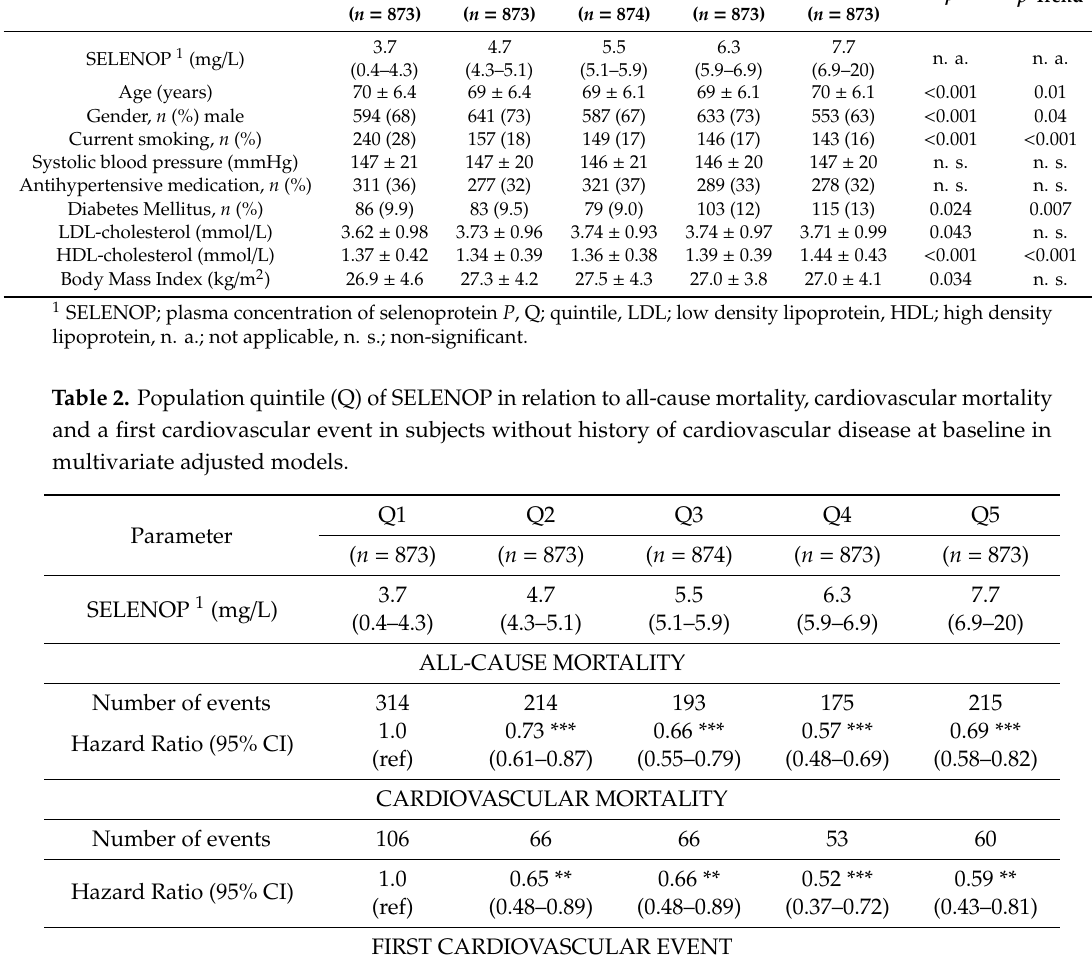
Table 1. Baseline clinical characteristics according to quintile (Q) of concentration of Selenoprotein-P (SELENOP) at baseline of the subjects analyzed who were without history of cardiovascular disease. Q1 Q2